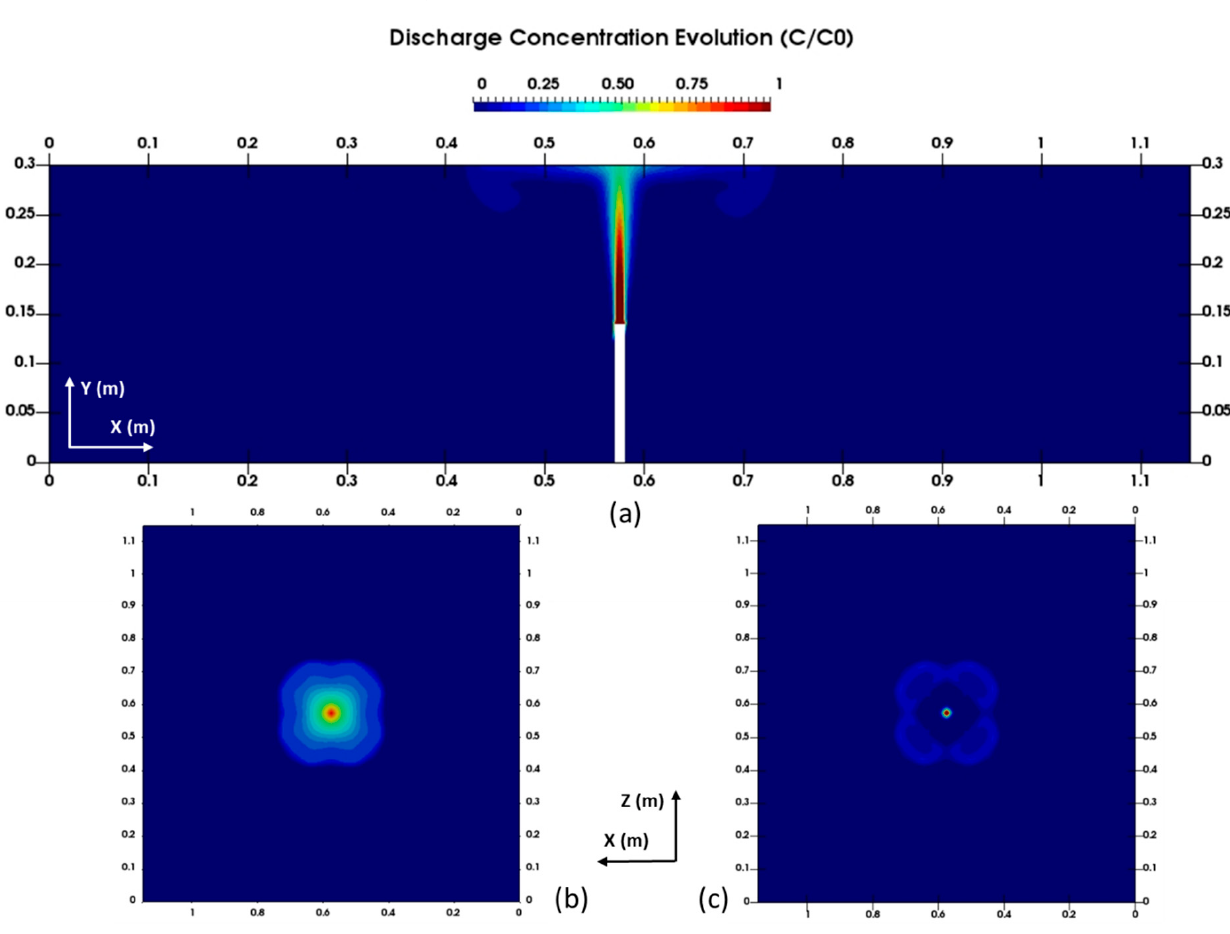
Figure 4. Vertical jet evolution in shallow water with surface interaction ( C 0 is the discharge concentration and C is discharge computed at each cell): ( a ) lateral cross section along the central plane, ( b ) top view at the water surface at t = 60 s, and ( c ) top view at the water surface at t = 20 s.